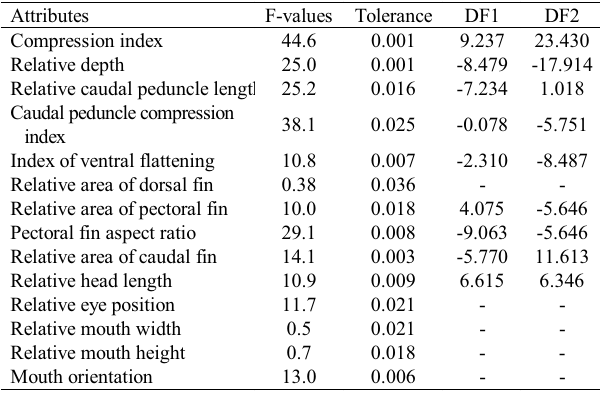
Table 4. F-values and tolerance values used to establish the relative importance of the attributes included in the discrimi- nant model, along with the respective coefficients expressing the correlation between each original variable and two ca- nonical discriminant functions (DF), standardized by within variances. Dashes (-) represent variables excluded from the model due to a combination of a low F-value (below 3.9) with a high tolerance value (above 0.001).